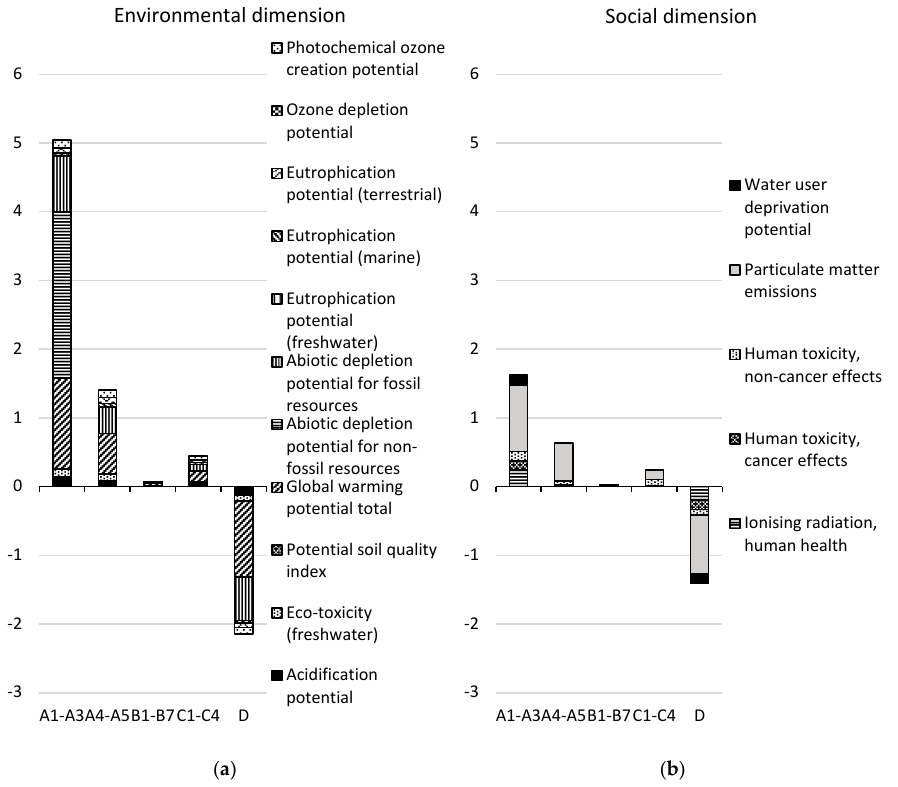
Figure 5. Normalized and weighted results for the SSC bridge design concept per life cycle stage in ( a ) the environmental dimension and ( b ) the social dimension per indicator and for the functional unit. Module B8 is not included. See Figure 4 for module B8. Note that the ozone depletion potential indicator bar cannot be seen in the figure since it is very small.